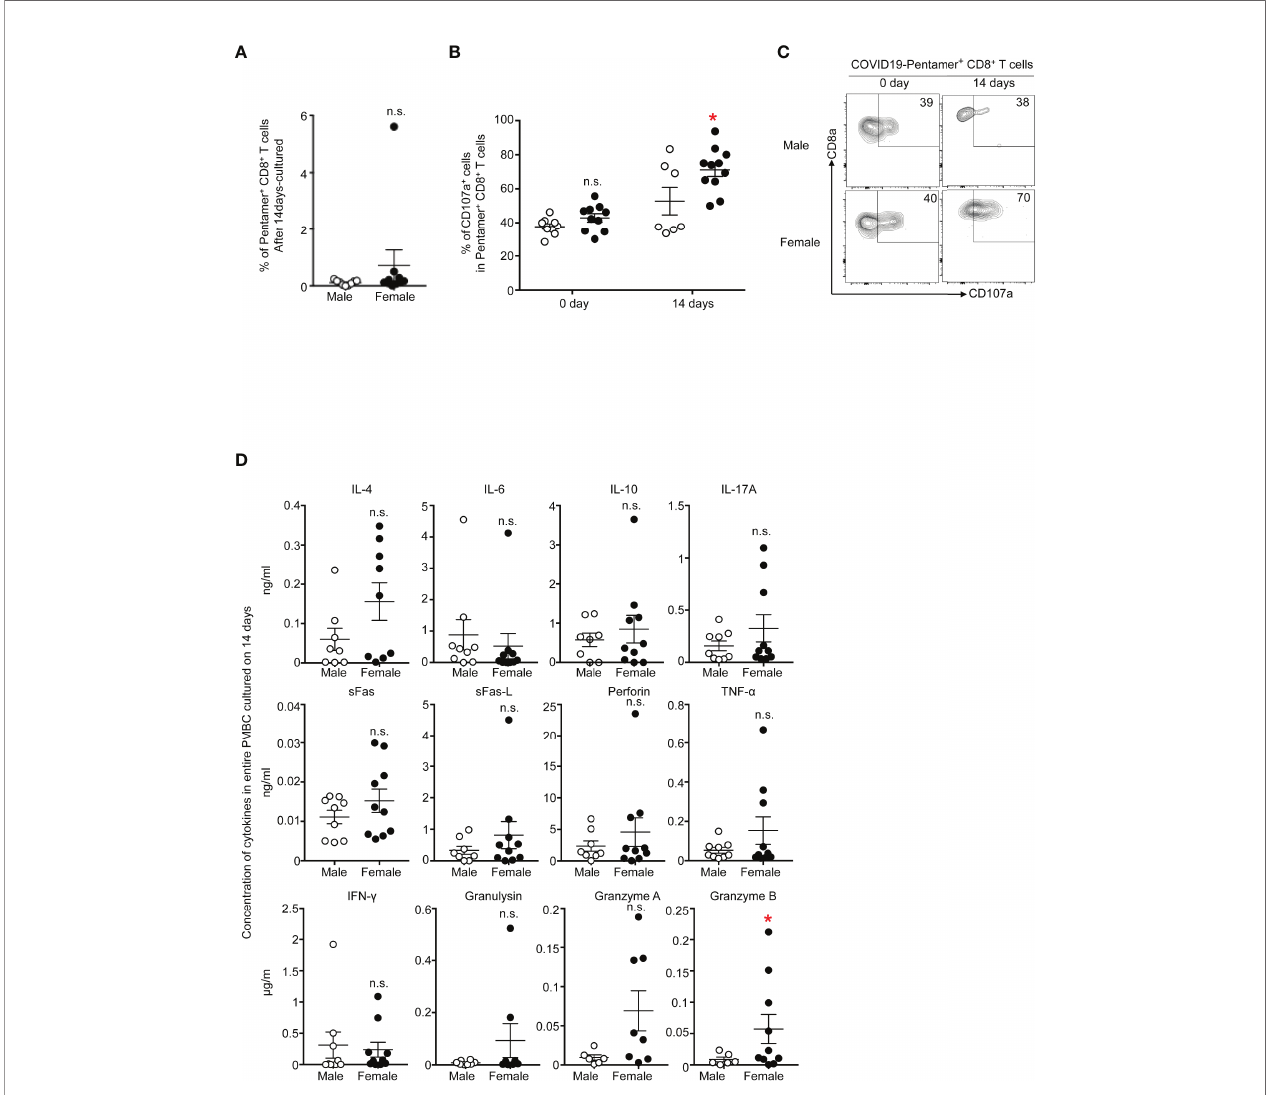
FIGURE 5 | (A) Frequency of PI-CD3+CD8+COVID-19-pentamer+ PMBCs from males and females cultured for 14 days. (B) Frequency of CD107a + COVID-19- pentamer + CD8 + T cells among PMBCs from males and females cultured for 0 days and 14 days. (C) Flow cytometric analysis of CD107a + COVID-19-pentamer + CD8 + T cells among PMBCs from males and females cultured for 0 days and 14 days. Dot plots of CD8 and CD107a expression in PI - CD3 + CD8 + COVID-19-pentamer + PMBCs are shown. (D) LEGENDplex ™ multianalyte fl ow assay of IL-4, IL-6, IL-10, IL-17A, sFas, sFas-L, perforin, TNF- a , IFN g , granulysin, granzyme A and granzyme B from PMBCs from males and females cultured for 0 days and 14 days. *p < 0.05; n.s., not signi fi